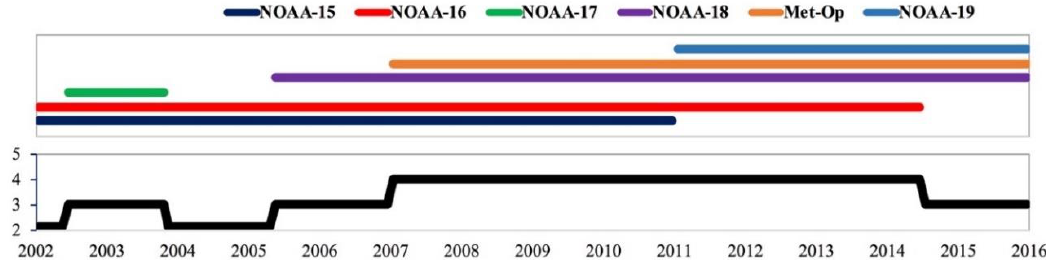
Figure 2. Temporal period for each satellite and the corresponding number of satellites for the period 2002 to 2016, when at least three satellites were in operation.